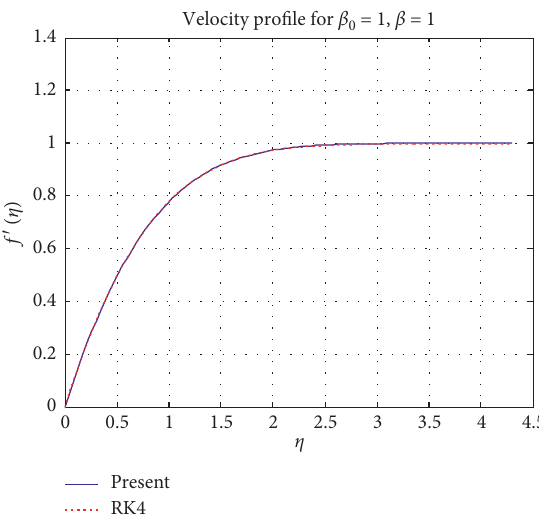
Figure 3: Velocity profile of the Homann axisymmetric stagnation � 1 and β � ½). f ″ ( 0 )� 0.927686124423 for L � 4.404. flow ( β 0